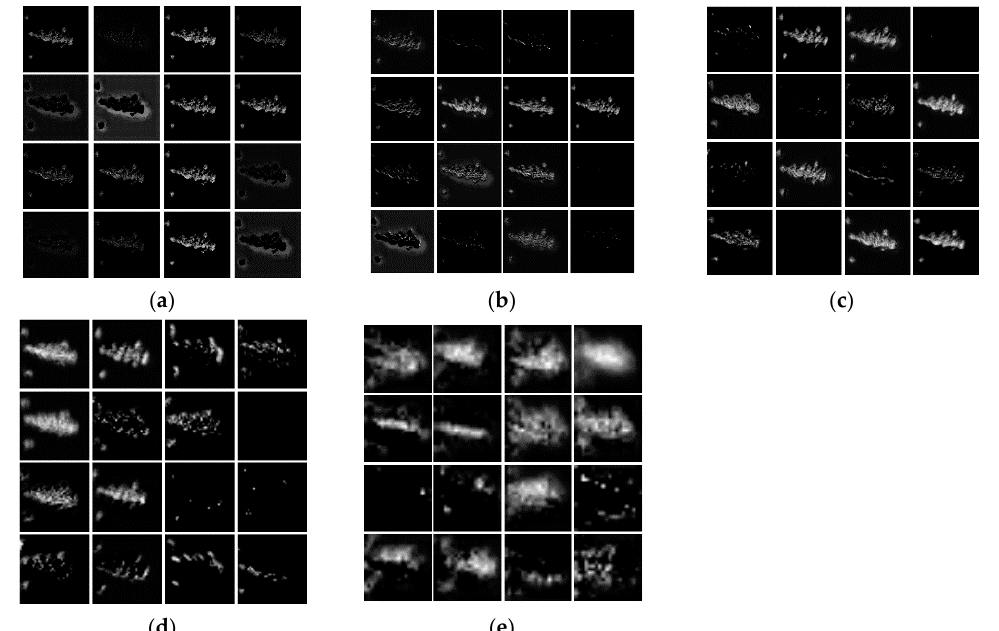
Figure 11. SAR image feature map visualization of the ( a ) 1st, ( b ) 3rd, ( c ) 5th, ( d ) 8th, and ( e ) 11th convolutional layer of 2S1.